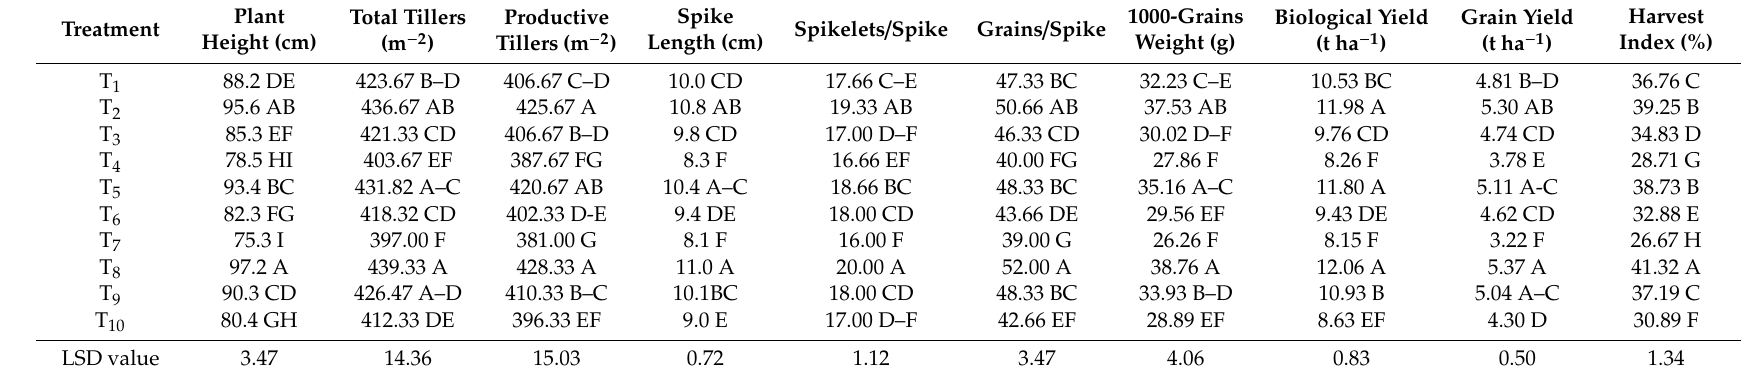
Table 4. Influence of di ff erent vermicompost (mature) treatments on the yield related attributes of